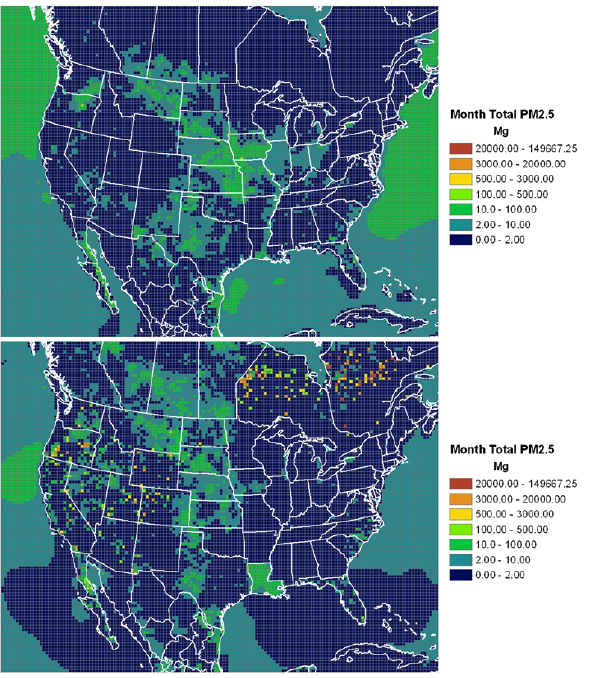
Fig. 9. Total natural PM 2.5 (sum of sulfate, nitrate, OC, EC, nonreactive and fine sea salt) emissions (Mg) calculated for January (top) and July (bottom) 2002 for the atmospheric modeling domain.